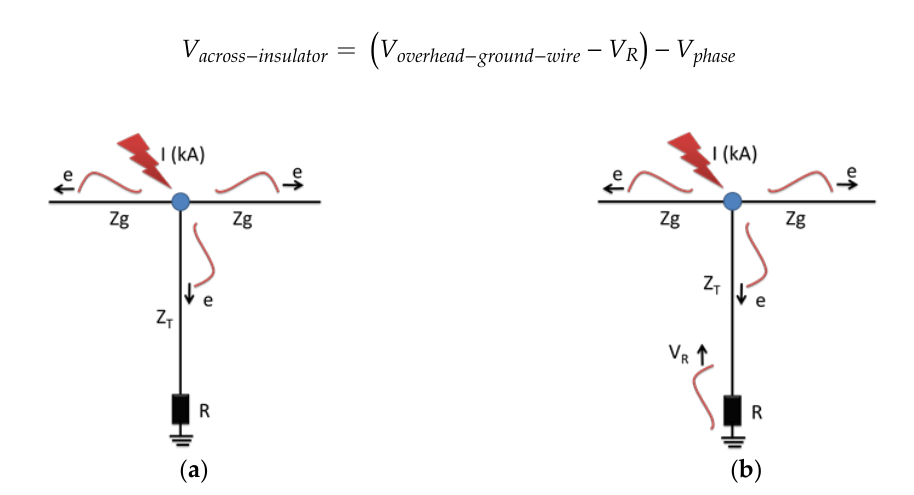
Figure 9. Result of a lightning strike to the overhead ground wire; ( a ) Strike to the overhead ground wire; ( b ) Reflected wave voltage. wire; ( b ) Reflected wave voltage.